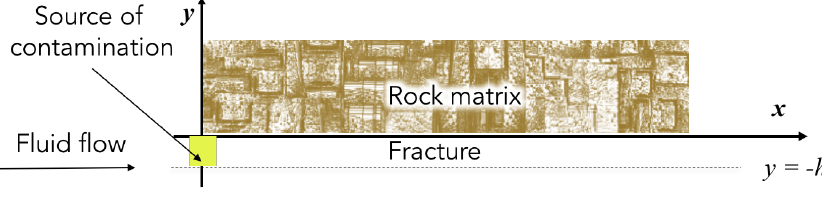
Figure 1. Schematic of a fracture surrounded with porous